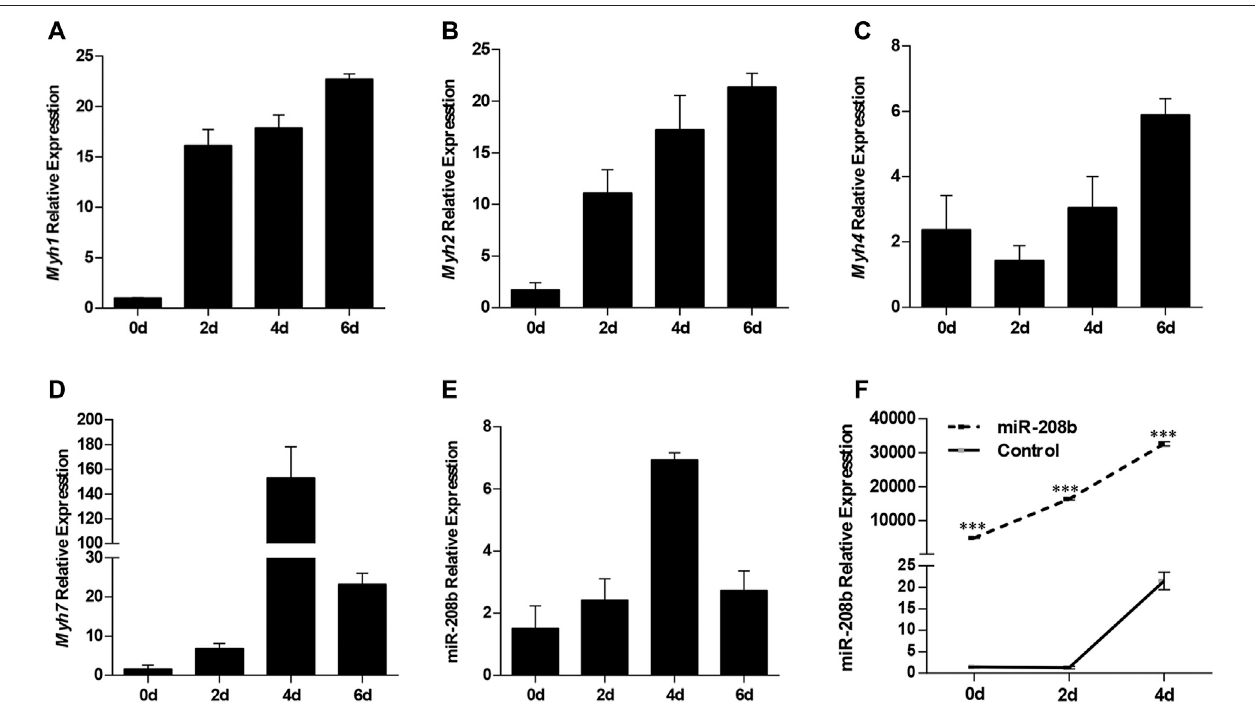
FIGURE 2 | The expression patterns of MyHC and miR-208b during of C2C12 cell myogenic differentiation. (A – E) : Expression levels of Myh1 (A) , Myh2 (B) , Myh4 (C) ,Myh7 (D) ,andmiR-208b (E) duringC2C12 myogenicdifferentiation ondays 0,2,4,and6. (F) RelativeexpressionlevelofmiR-208bduringC2C12myogenic differentiation on days 0, 2,and 4 post transfections with miR-208b mimics and control vectors, respectively.Statistical comparisons areperformedusing ordinaryone- way ANOVA in (A – E) and using multiple t -tests in (F)